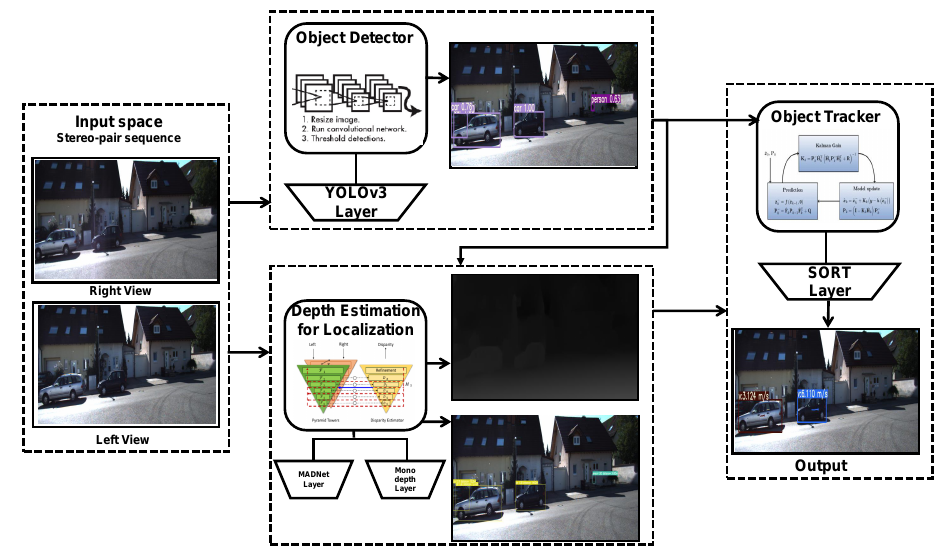
Figure 1. Overview of the proposed system composed of three main components: object detection, depth estimation and localisation and